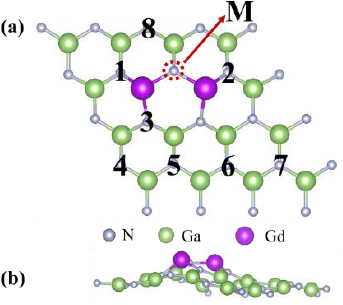
Figure 1. ( a ) Top and ( b ) side views of the optimized structures of Ga 14 N 16 Gd 2 monolayers.